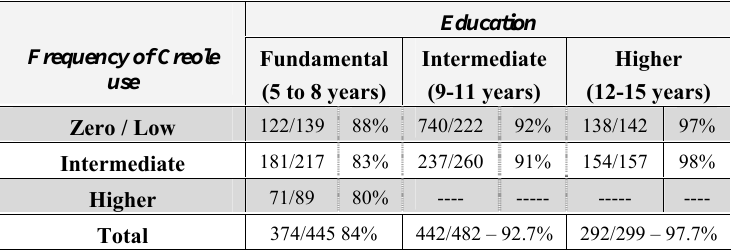
Table XV: Third person plural marking in PST (all